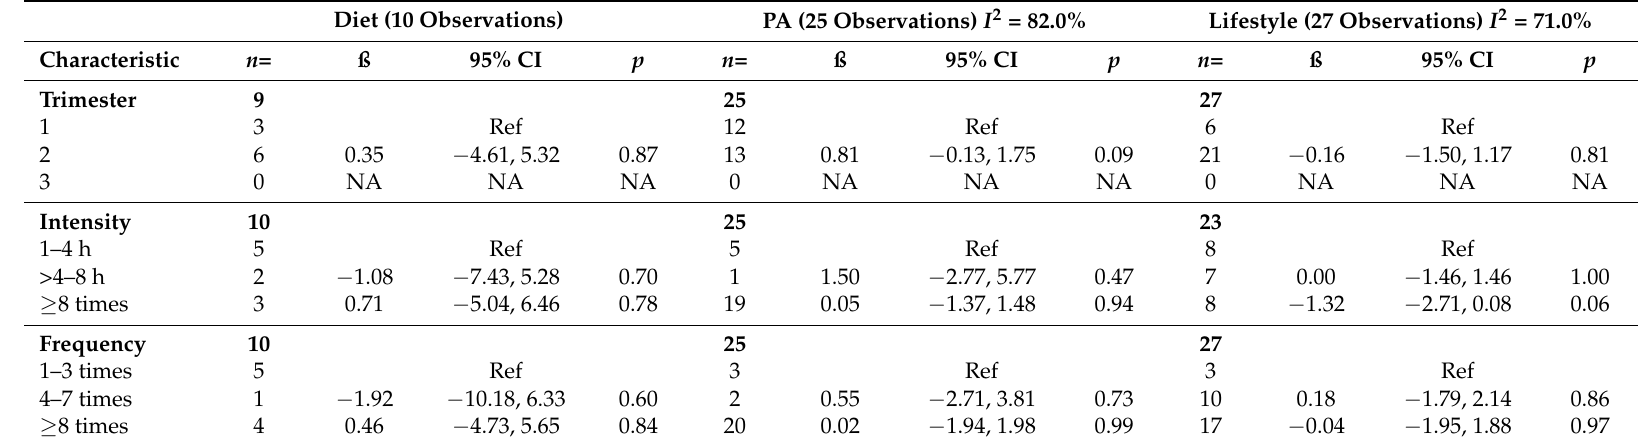
Table 2. Meta-regression of characteristics of diet and lifestyle interventions designed to prevent excessive